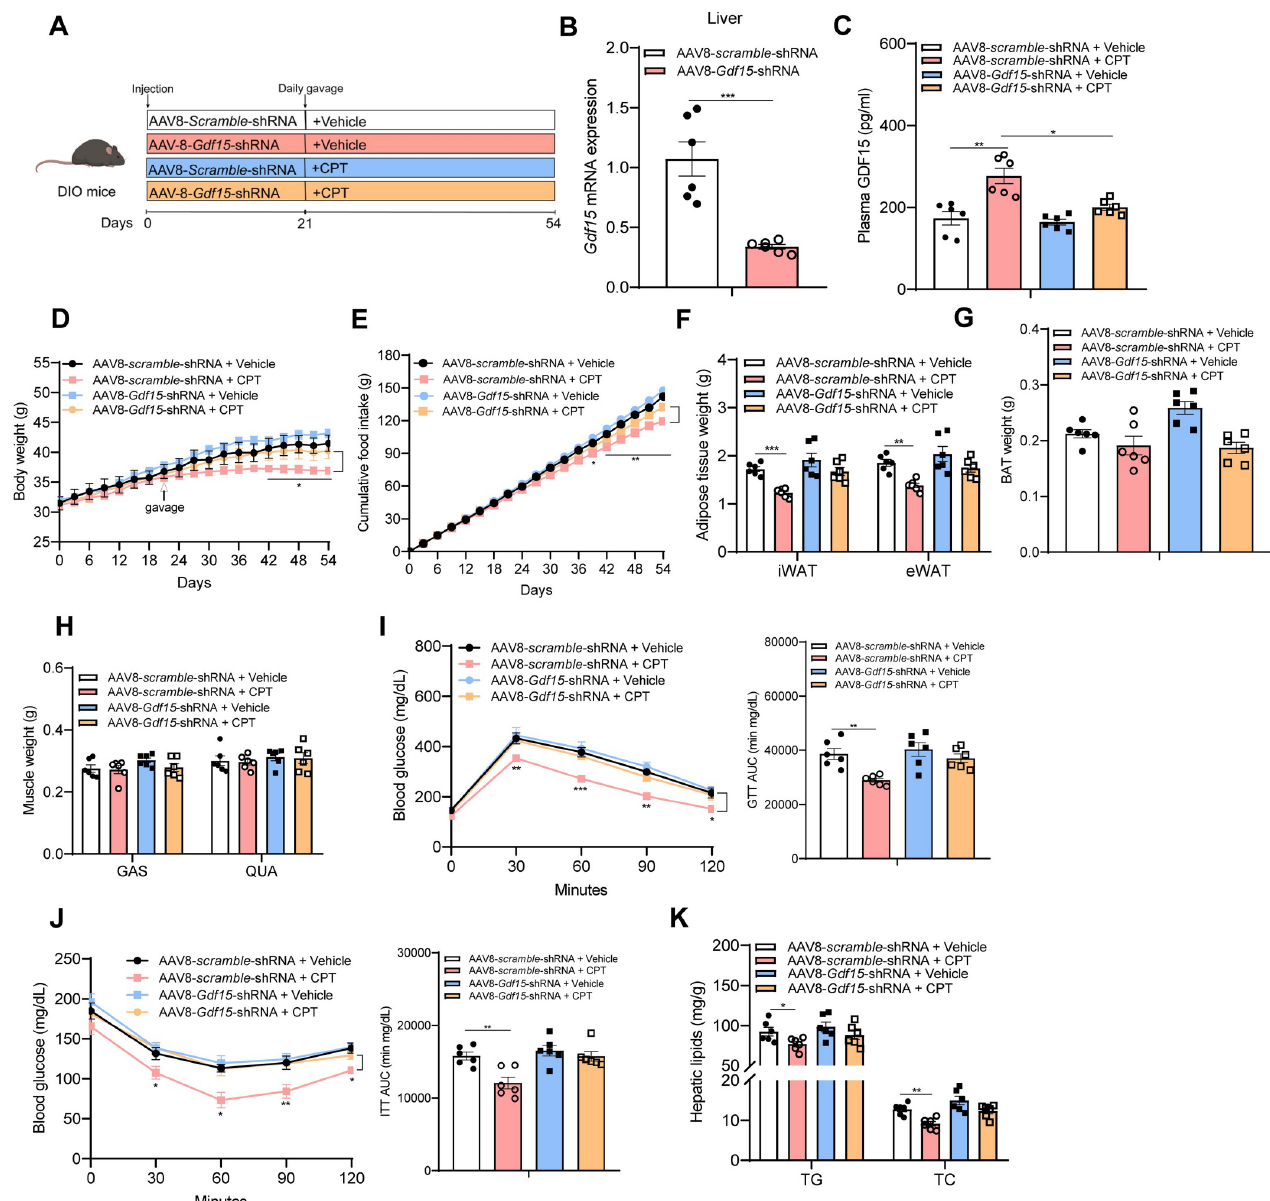
Fig 5. CPT-induced GDF15 expression derives mainly from the liver. (A-K) Animal protocol 3 : (A) Schematic diagram of mice treatment. Created with biorender.com. DIO mice were intravenously injected once with adenovirus (AAV8- scramble -shRNA or AAV8- Gdf15 -shRNA) through the tail vein (1 × 10 11 vector genomes/mouse). After 21 days, mice were treated daily with either vehicle or CPT for 33 days. Thus, 4 groups of mice (vehicle + AAV8- scramble - shRNA, vehicle + AAV8- Gdf15 -shRNA, CPT + AAV8- scramble -shRNA, and CPT + AAV8- Gdf15 -shRNA) were studied here. (B) Hepatic Gdf15 mRNA expression and (C) plasma levels of GDF15 after 33 days of treatment. (D) Consecutive body weight. (E) Cumulative food intake. (F-G) Adipose tissue weight. (H) Mass of GAS and QUA. (I) GTT was performed after 42 days of treatment and AUC of GTT. (J) ITT was performed after 49 days of treatment and AUC of ITT. (K) Hepatic TG and TC contents. Data are presented as mean ± SEM. � P < 0.05, �� P < 0.01, ��� P < 0.001. n = 6 per group. The underlying data for this figure can be found in S1 Data . AUC, area under the curve; BAT, brown adipose tissue; CPT, Camptothecin; DIO, diet-induced obese; GAS, gastrocnemius; GDF15, growth differentiation factor 15; GTT, glucose tolerance test; ITT, insulin tolerance test; QUA, quadriceps; TC, total cholesterol; TG,